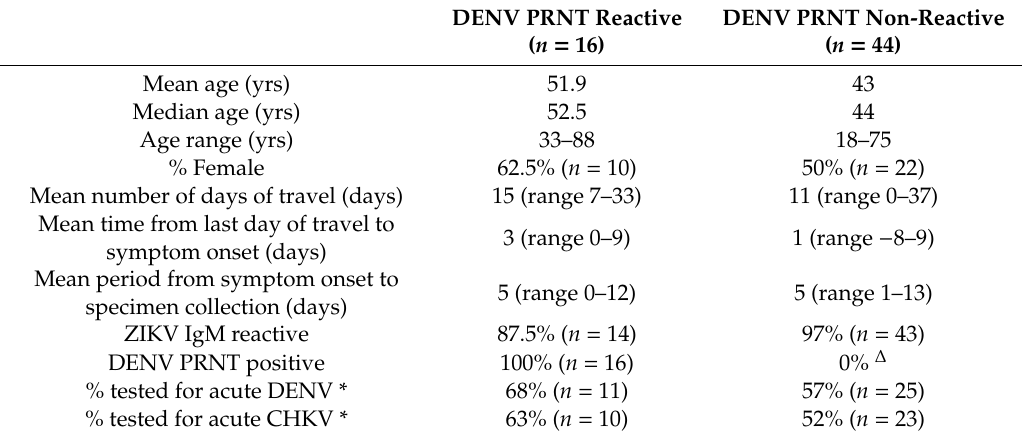
Table 1. Characteristics of Zika virus (ZIKV)-positive patient